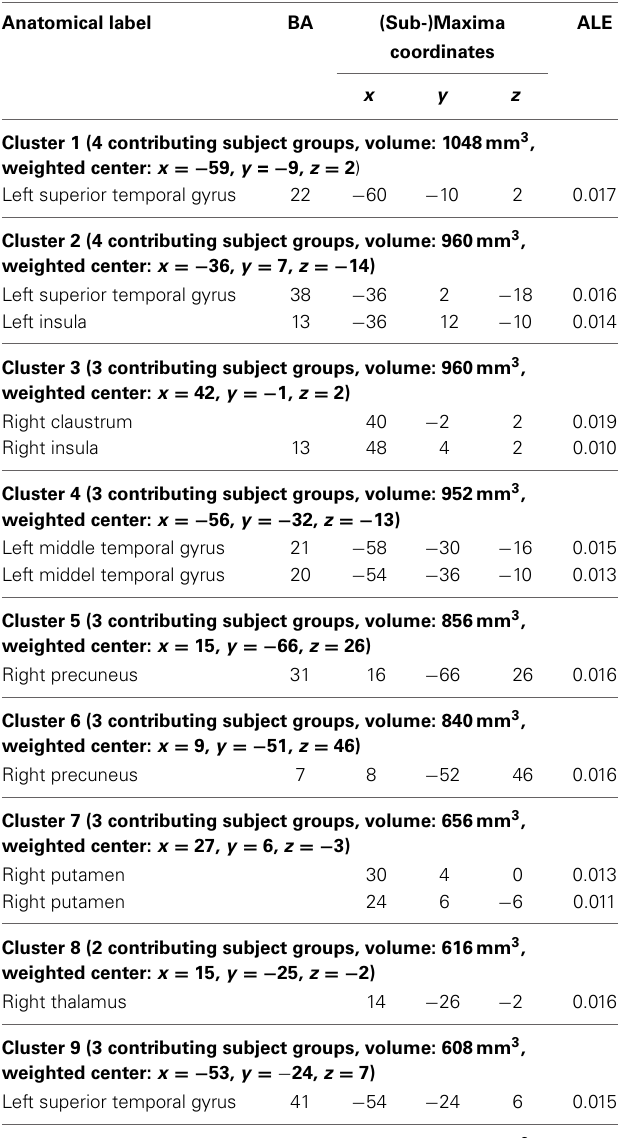
Table 4 | Brain areas (cluster-information and peak voxels) with significant convergence across studies in Group B (increased connectivity/activity in